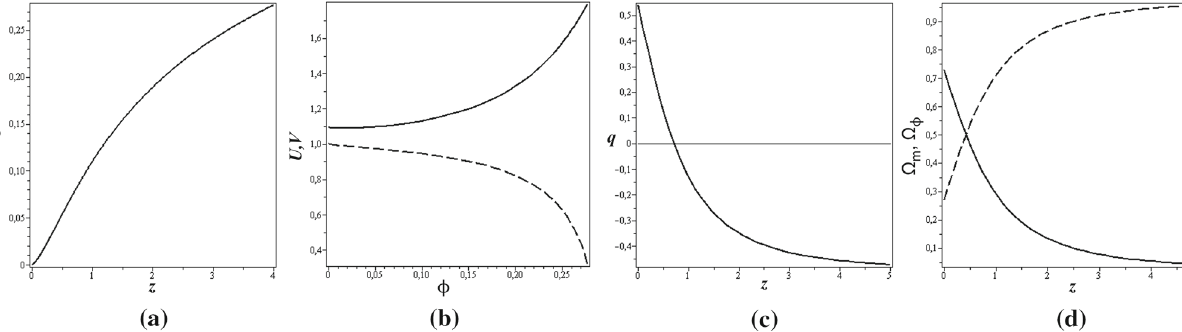
φ = 0, H = 1, ω = − 1, ω = 0 . 1 and 0 0 0 1